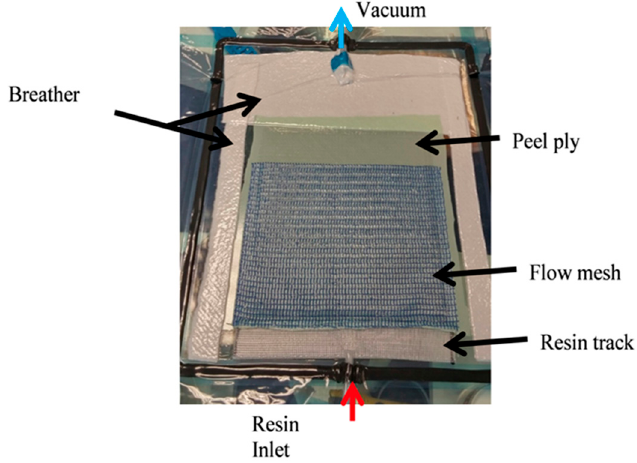
Figure 2. Vacuum assisted resin infusion (VARI) set-up.